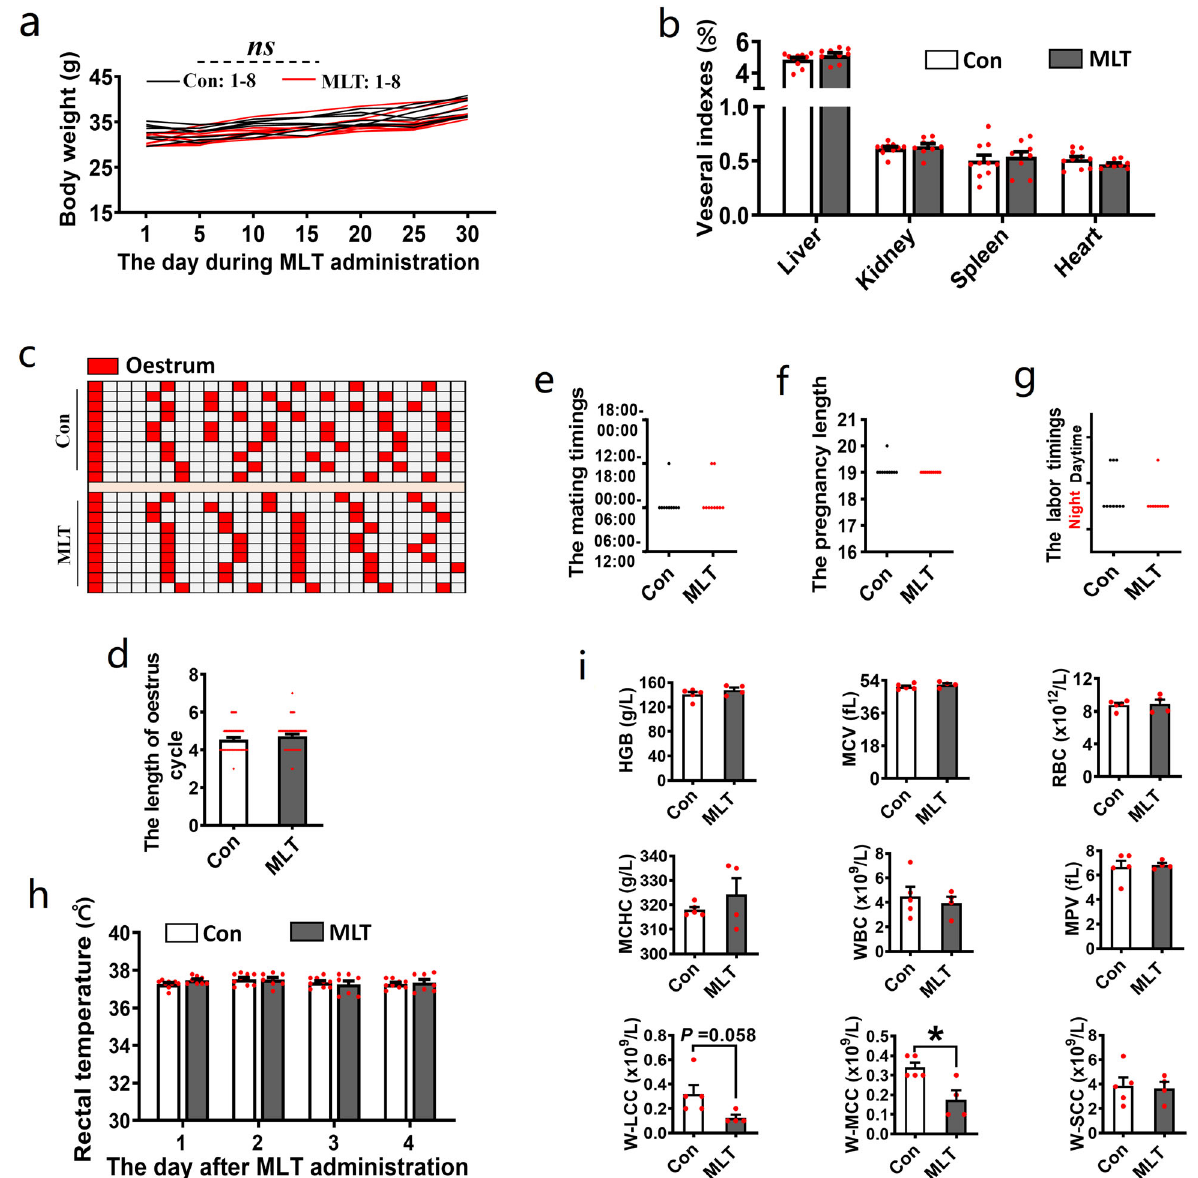
Fig. 6 Long-term intake of excessive MLT did not disturb the reproductive rhythm, growth, and health of mice. a The effect of MLT intake on daily weight gain. n = 8 biologically independent mice. b The effect of MLT intake on visceral indexes. n = 10 (Con), 9 (MLT) biologically independent mice, respectively. c , d The effect of MLT intake on estrous cycle. c The chart of estrus records, red grids represent estrum, and the distance between two adjacent red grids represents the length of an estrus cycle. d The statistical chart of estrus cycle length. n = 10 biologically independent mice. e The effect of MLT intake on mating timings of female mice. n = 10 biologically independent mice. f The effect of MLT intake on pregnancy length. n = 10 biologically independent mice. g The effect of MLT intake on labor timings. n = 10 biologically independent mice. h The effect of MLT intake on body